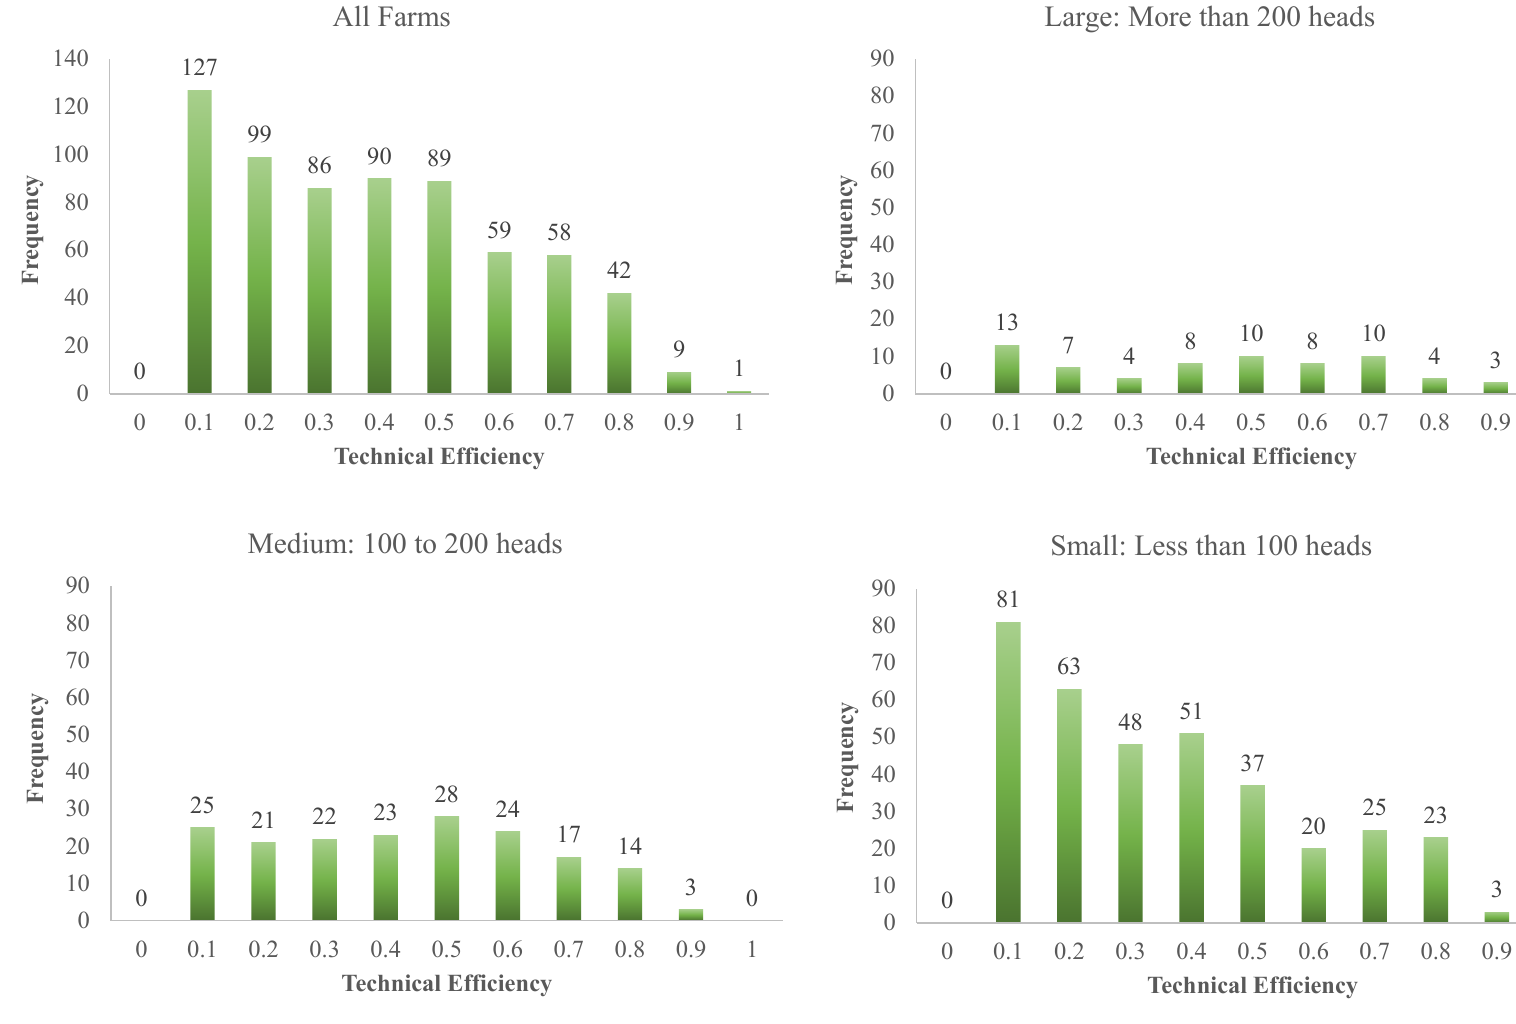
Figure 3. Goat technical efficiency distribution